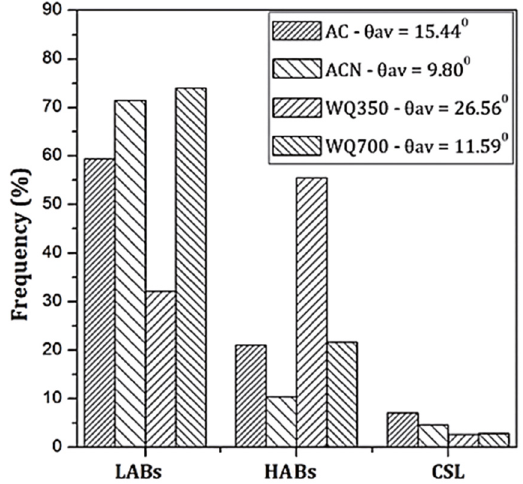
Figure 7: Distribution of boundary characteristics in investigated